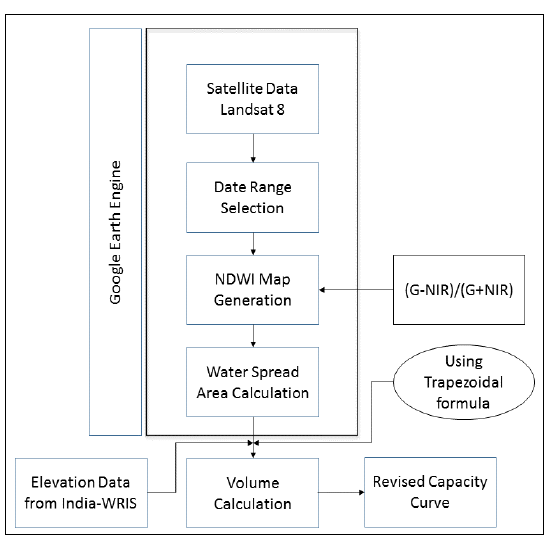
Fig. 3. Methodology